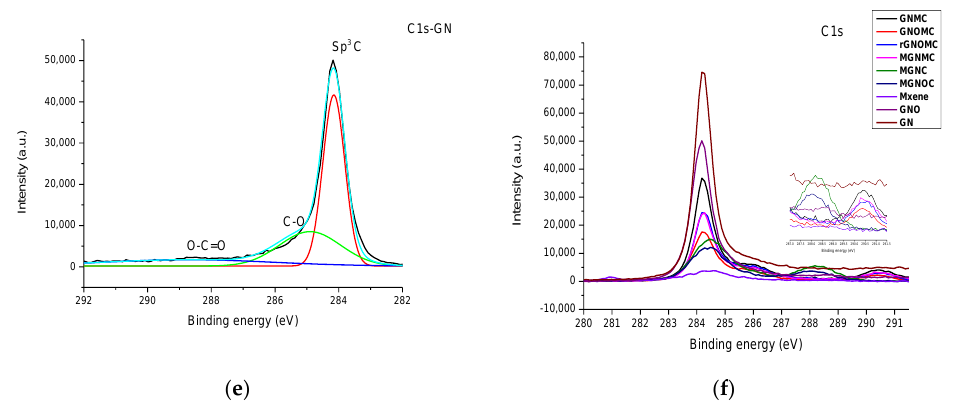
Figure 4. XPS fitting curves of Ti 3 C 2 T x ( a ) Ti2p ( b ) C1s, ( c ) O1s, ( d ) F1s, and ( e ) fitting curve of the GN C1s; ( f ) overlapping curves of GNO, rGNO, GN, MXene, and graphene/ MXene-graphene composites. Table 1. Atomic percentages of Ti 3 C 2 T X , GN, GNO, rGNO, and composites from XPS analysis.